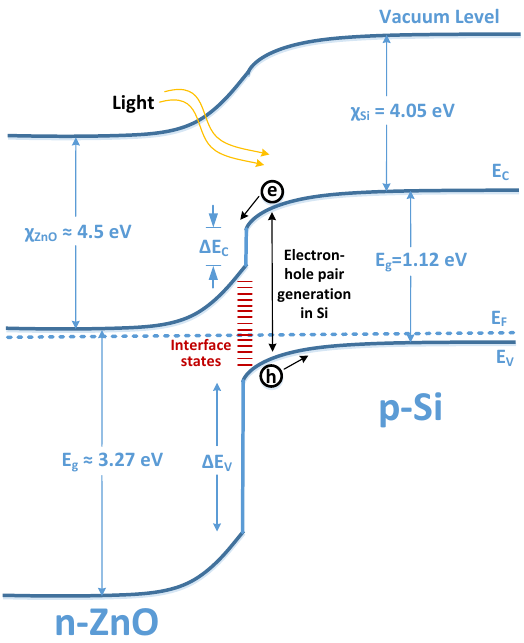
Figure 2. Schematic diagram of n-ZnO/p-Si heterojunction band-bending. χ denotes electron affinity of the material mentioned in the subscript.